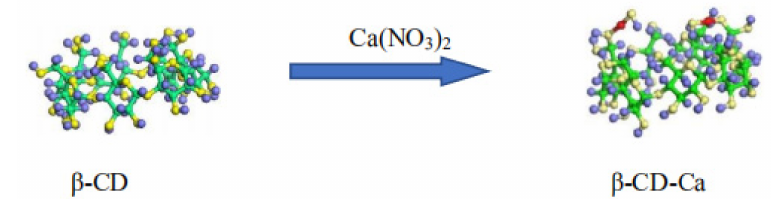
Figure 10. Synthesis diagram of β -CD-Ca.